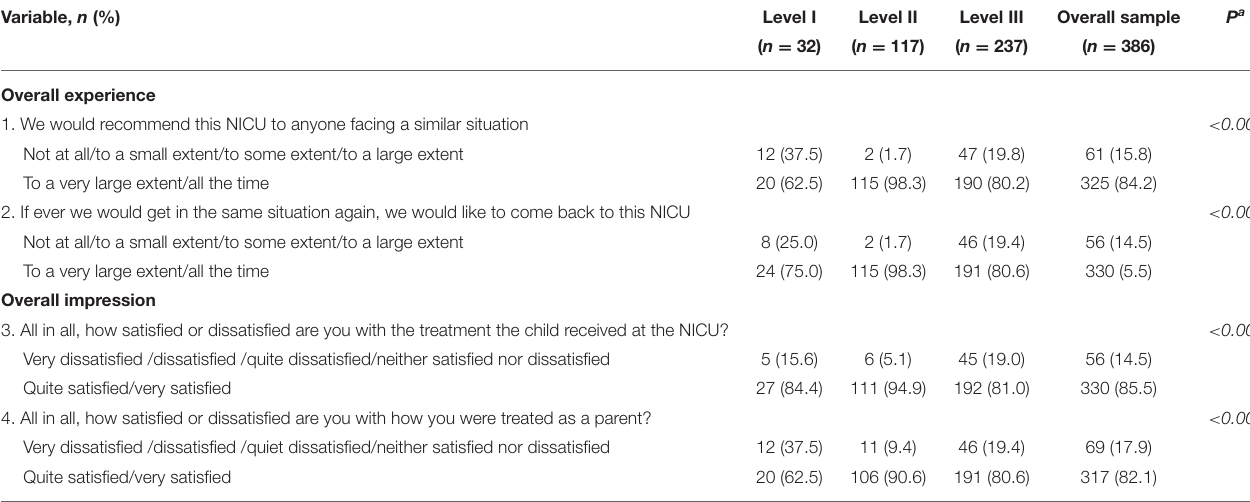
TABLE 6 | General questions on parents’ experience and impression.